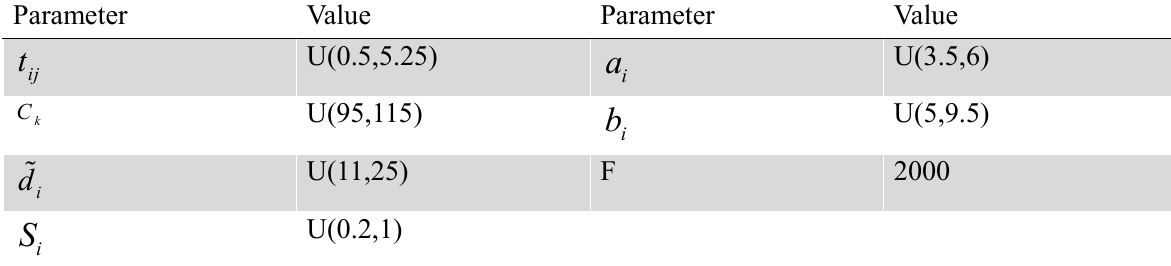
Sources of random generation of the